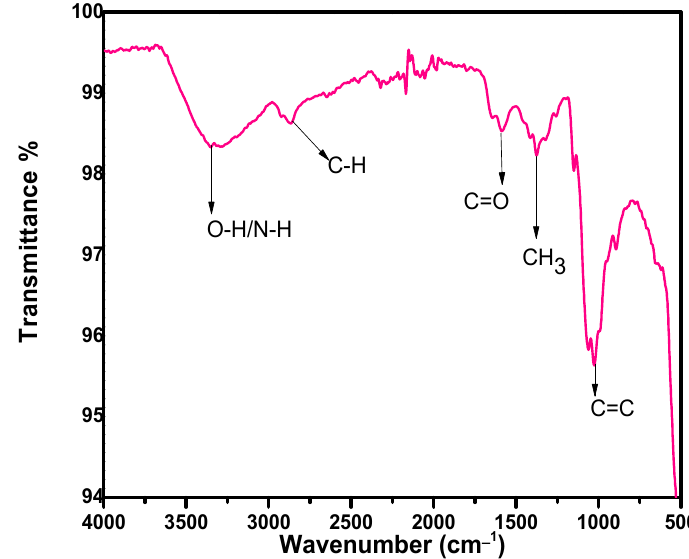
Figure 1. FTIR spectrum of chitosan.